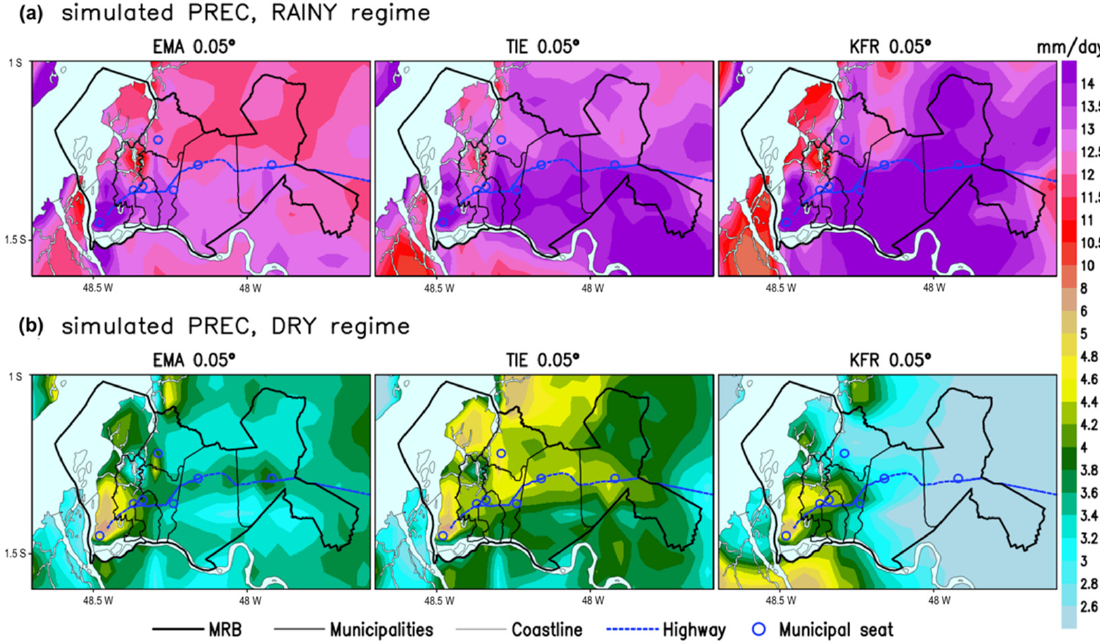
Figure 5. RegCM4 simulated PREC (mm/day) using EMA, TIE, and KFR schemes for ( a ) RAINY; ( b ) DRY regime.